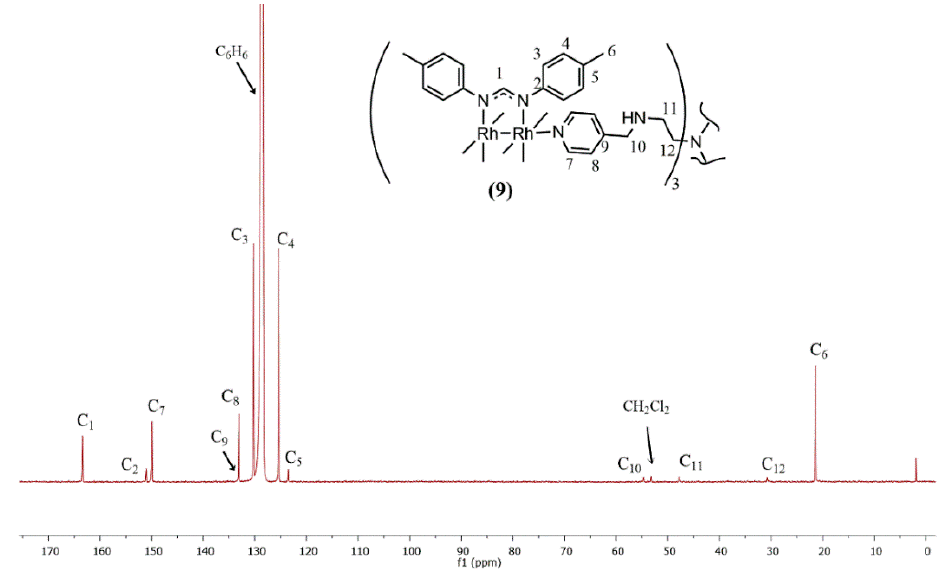
Figure 5. The 13 C-NMR spectrum obtained for 9 in benzene- d 6 .